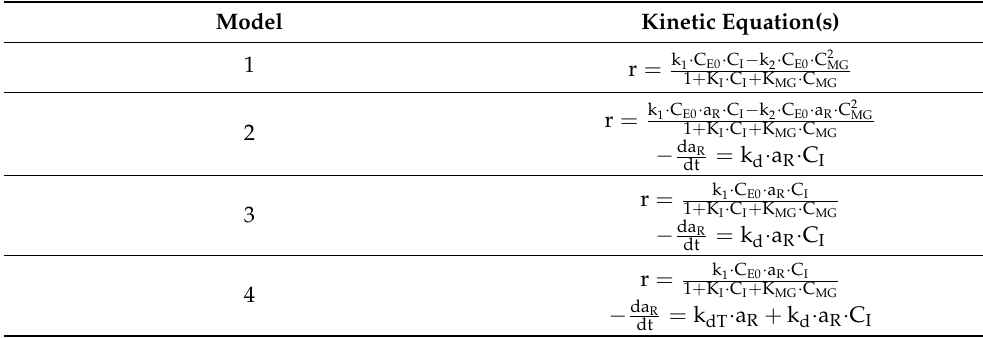
Table 4. Kinetic equations corresponding to the proposed kinetic models to fit to the triphasic glycerol-toluene (+ibuprofen)-N435 data (fitting each model to all retrieved